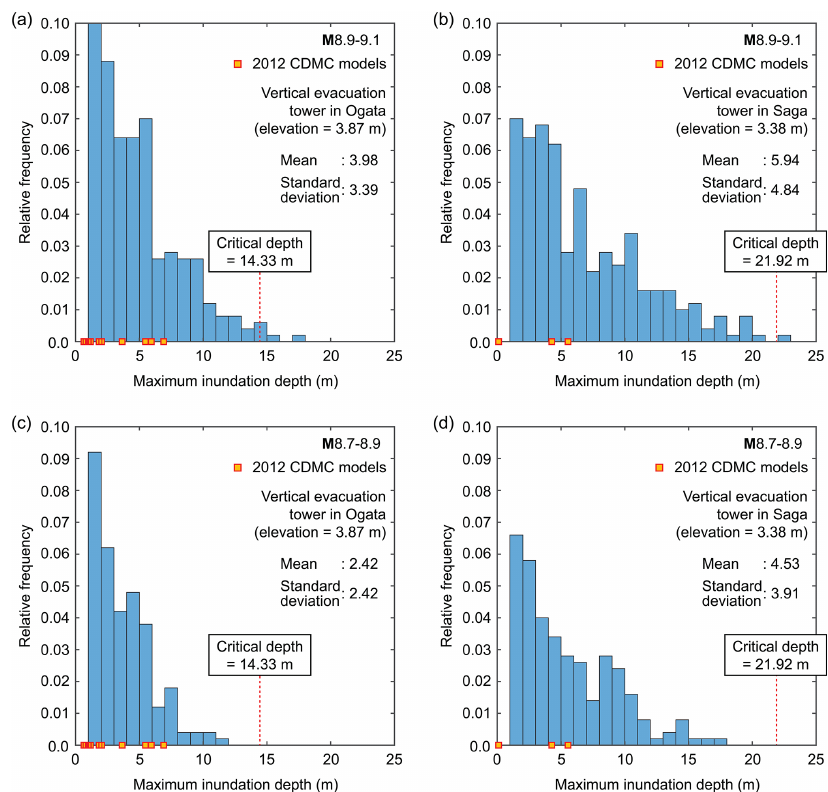
Figure 11. Histograms of maximum inundation depth at the vertical evacuation towers in the Ogata and Saga districts (see Fig. 4) for the two magnitude ranges M 8.9–9.1 (a, b) and M 8.7–8.9 (c, d) . The sum of the vertical bin heights is 1.